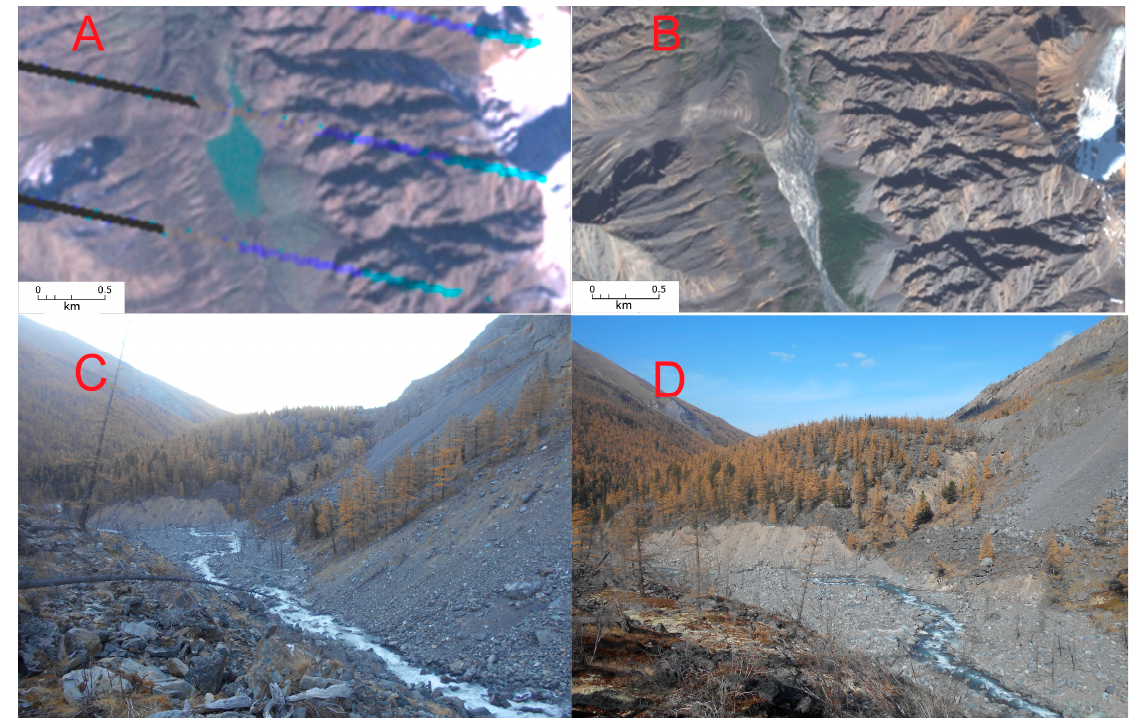
Figure 21. Changes in the valley of the Maashei river associated with the outburst of the lake. ( A ) Landsat 7 image; ( B ) Sentinel image; ( C ) new riverbed dug by mudflow; ( D ) stream traces on the opposite side of the valley.